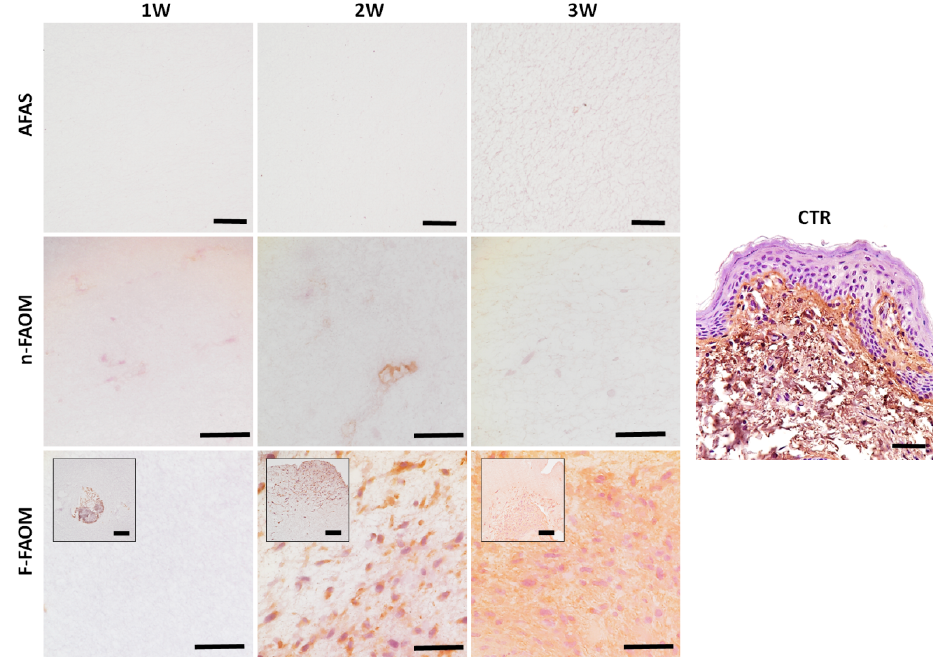
Figure 6. Immunohistochemical analysis of controls and biofabricated oral tissues using type-I collagen primary antibodies. CTR: control native oral mucosa; AFAS: acellular fibrin–agarose sca ff olds; n-FAOM: non-functionalized fibrin–agarose oral mucosa stroma substitutes using isolated primary cell cultures of human oral mucosa fibroblasts immersed in fibrin–agarose sca ff olds; F-FAOM: functionalized fibrin–agarose oral mucosa stroma substitutes using oral mucosa tissue explants directly immersed in fibrin-agarose sca ff olds. 1W: samples kept in vitro 1 week; 2W: samples keep in vitro 2 weeks; 3W: samples keep in vitro 3 weeks. Scale bars: 100 µ